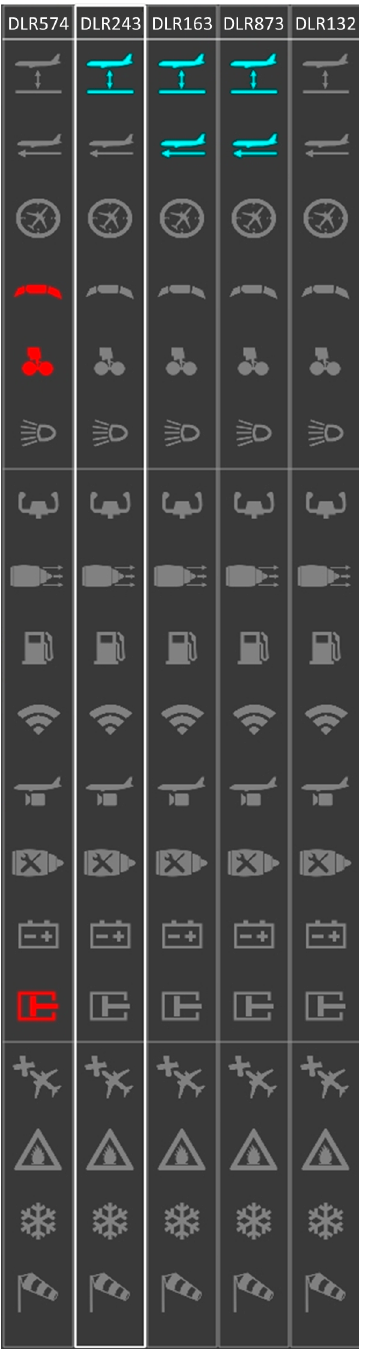
Figure 2. Icon display of the U ‐ FLY GCS during a hydraulic pump failure for the RPAS ‐ labeled DLR574, leading to the inability to deflect flaps and the landing gear, which is indicated by the red hue of the corresponding icons.